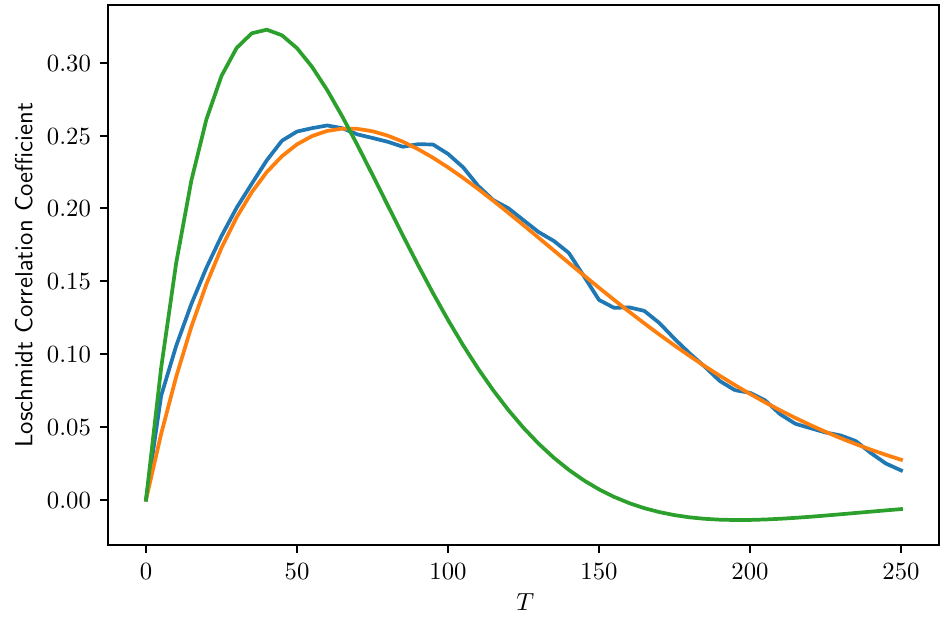
Figure 6 . The numerical results (blue) line up almost perfectly with the higher-cumulant predic- tions of equation (2.11) (orange), far outperforming the two-cumulant prediction